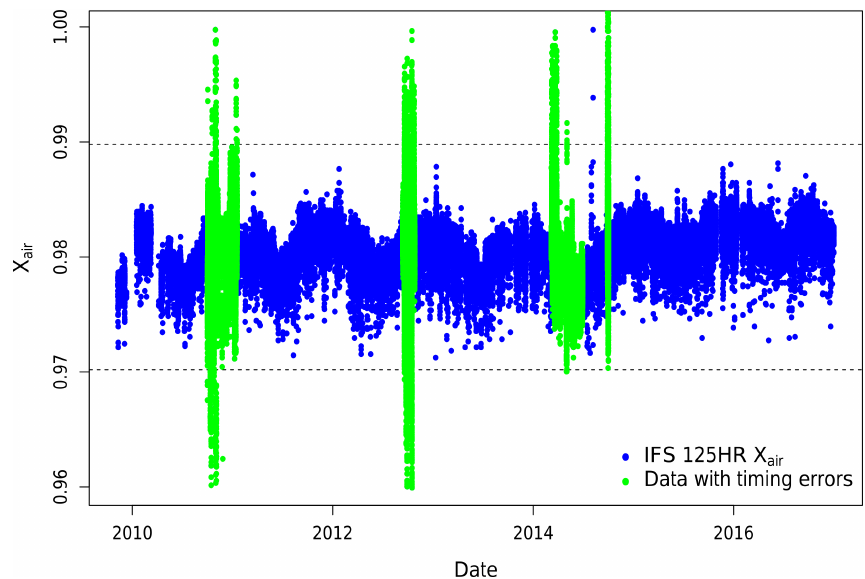
Figure 3. Time series of IFS 125HR X air . Data affected by timing errors are shown in green and defined in Table 2. For values not affected by timing errors, only every 10th data point is plotted for clarity.